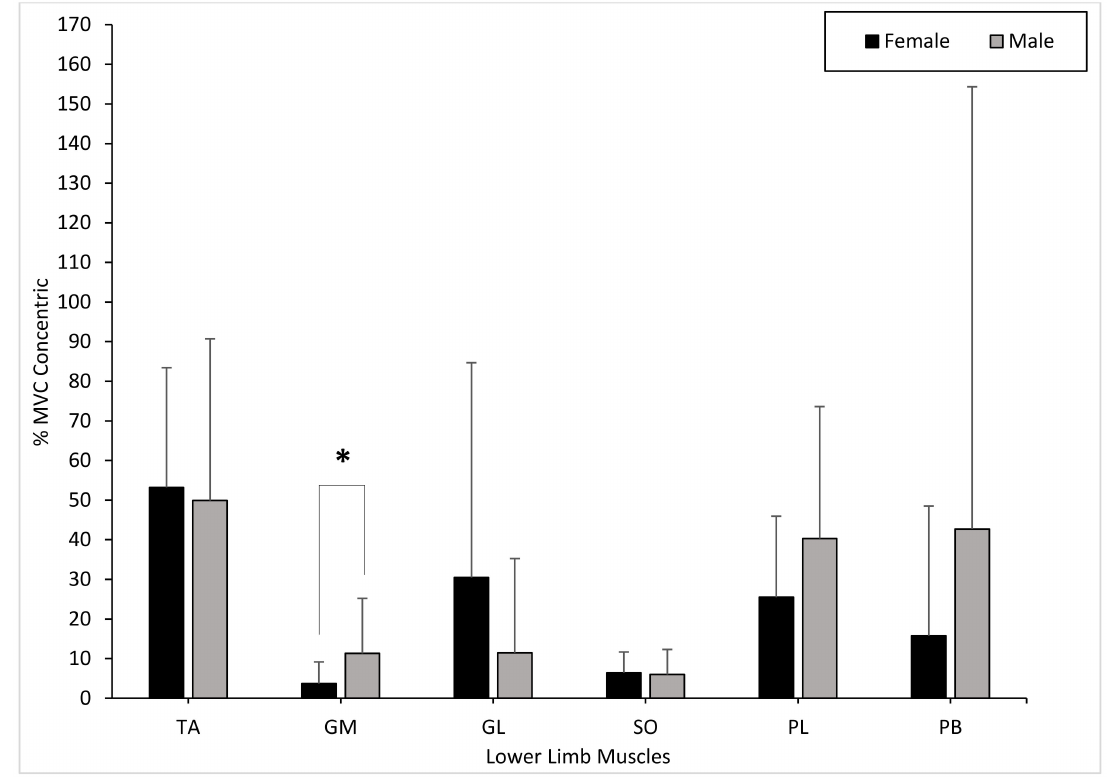
Figure 4. Mean gender differences in muscle activation (TA, GM, GL, SO, PL, and PB) within the dominant limb during the concentric phase with error bars ( ± standard deviation; * statistical